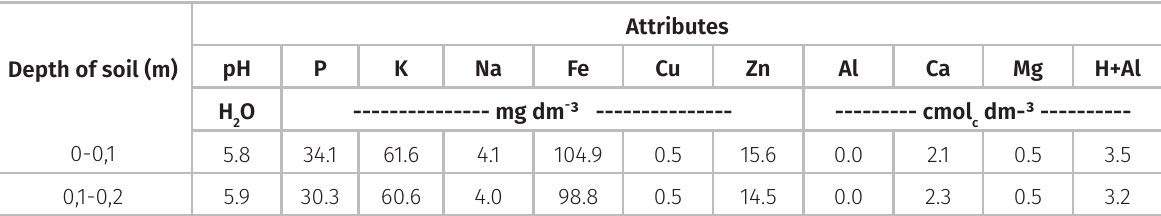
Table I. Chemical characterization of the soil before the experiment.